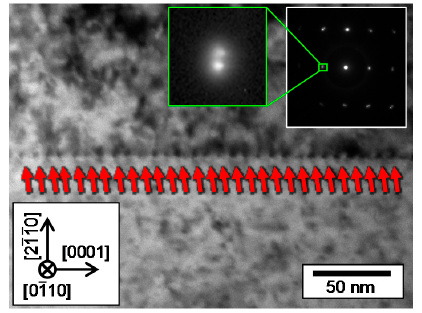
Figure 3. A typical bright field TEM image of the (21 (cid:3364) 1 (cid:3364) 0)/[011 (cid:3364) 0] 2° tilt grain boundary taken along [011 (cid:3364) 0]. A corresponding selected-area diffraction pattern is inset right above.